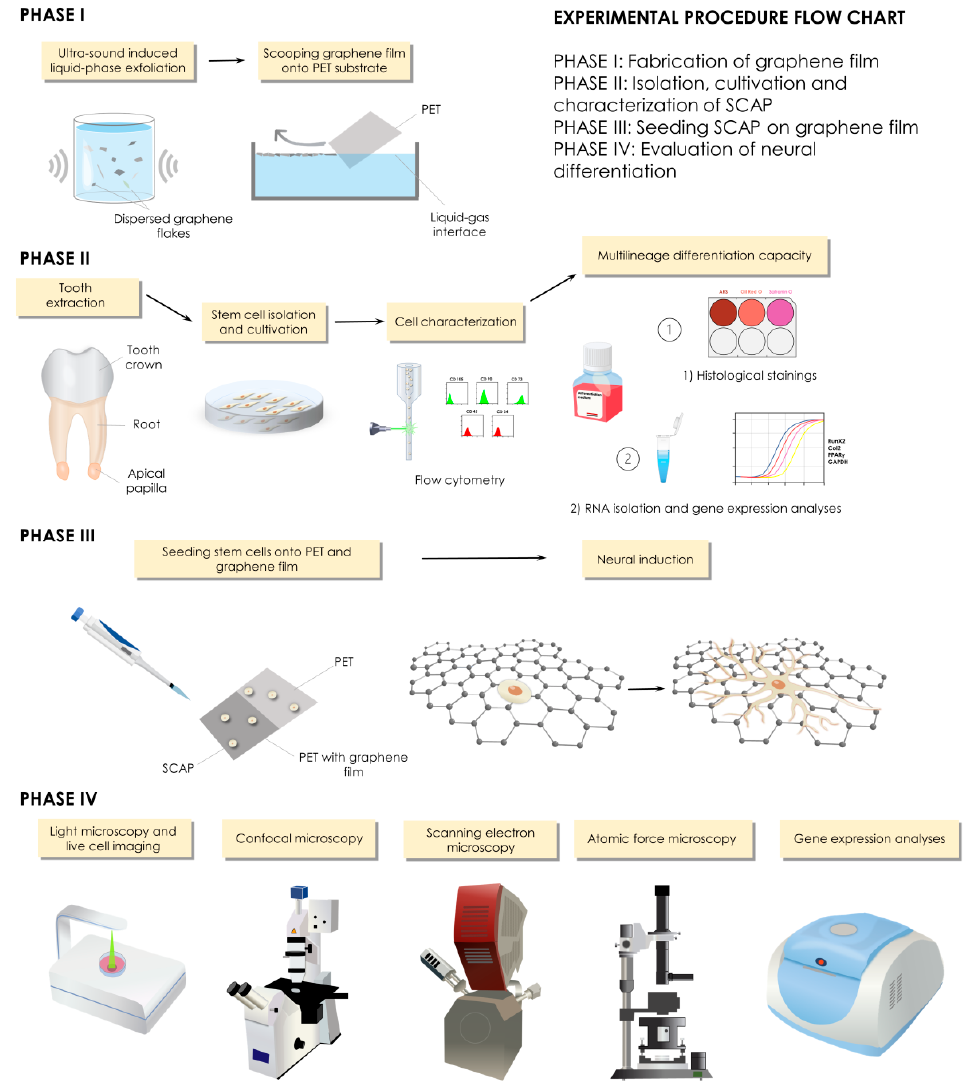
Figure 1. Study design and experimental procedures.